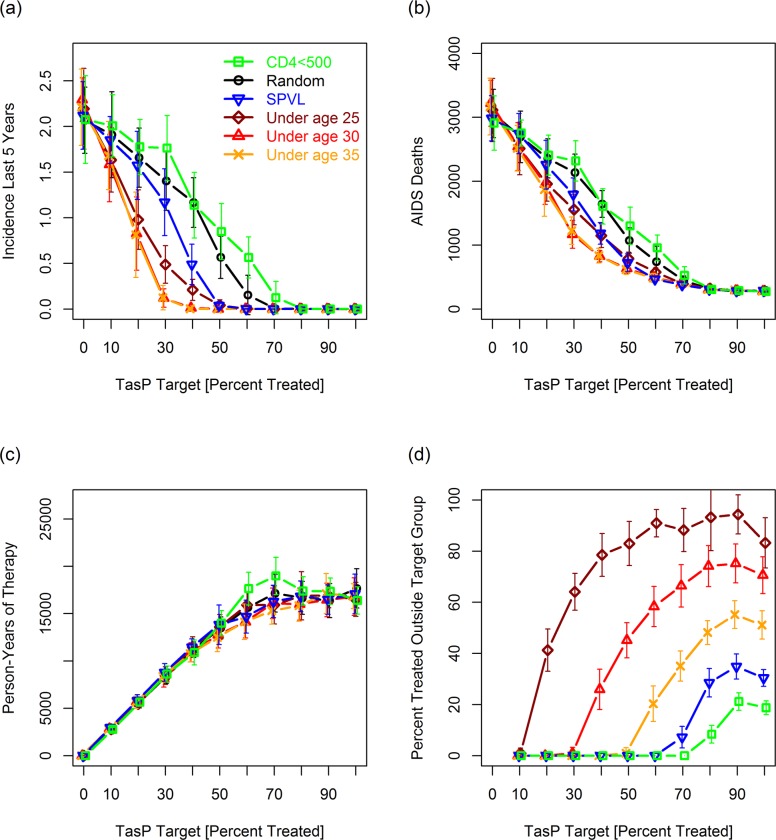
Effect of targeting strategy and the TasP target (Starg) on: (a) incidence 20–25 years after the TasP campaign, (b) AIDS deaths between years 0 and 25, (c) person-years of therapy (included to demonstrate that the age-based strategies did not inadvertently result in more people being treated), and (d) the percentage of HIV+ people initiating treatment at the start of the TasP campaign who were not a member of a target group. For random (untargeted) TasP, the values in panel d will always be 100% (data omitted from graph). The apparent decline in panel d between 90% and 100%, a decline not seen in other experiments, reflects statistical noise accentuated by the fact that only 95% of the population is linkable in this simulation (i.e., Starg = 100% translating to 95% suppression). Each point is the mean of 16 replicates. Bars give standard deviations (SDs). For normally distributed data, 95% confidence intervals would be ~55% the width [since t0.025,15 *SD/sqrt(15) = ~0.55*SD]. For this simulation, we set the initial population size to 10,000. In this and subsequent figures we assumed sudden pre-TasP rollouts so that the TasP campaign will roughly double the number of virally suppressed people.